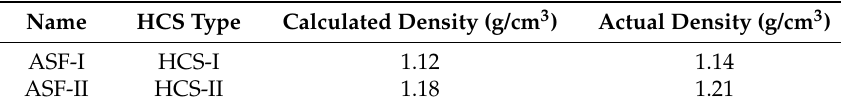
Table 3. The calculated value and actual value of the